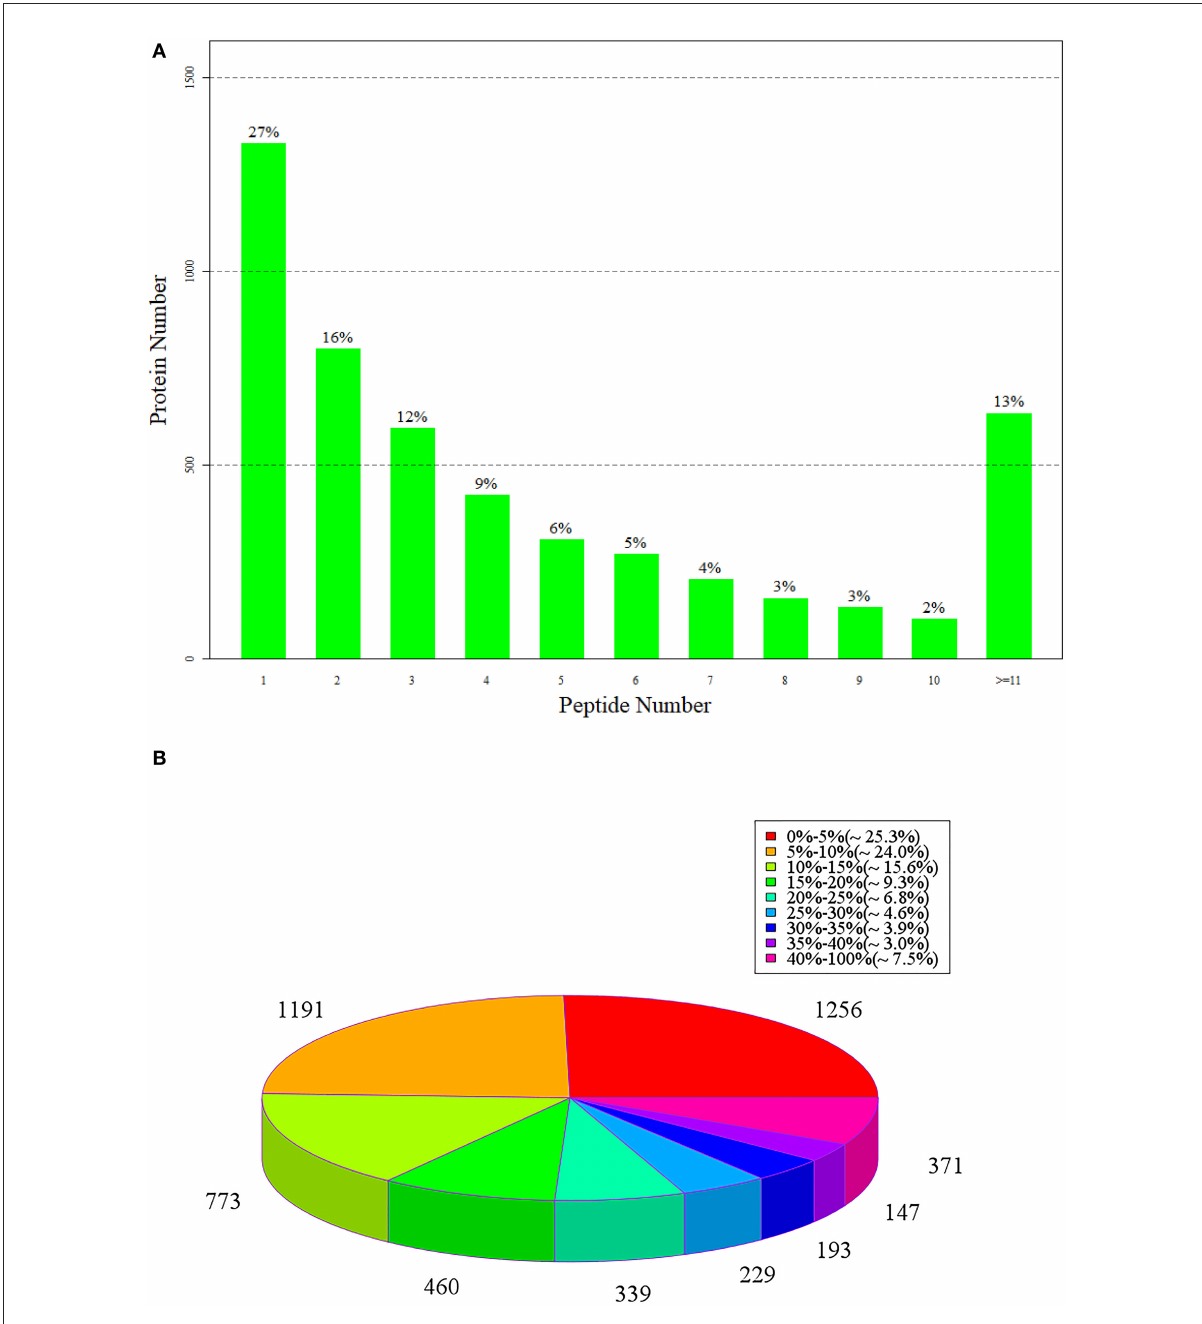
FIGURE5 (A) The number of peptides matched to proteins; (B) is the statistical diagram of protein identification coverage.